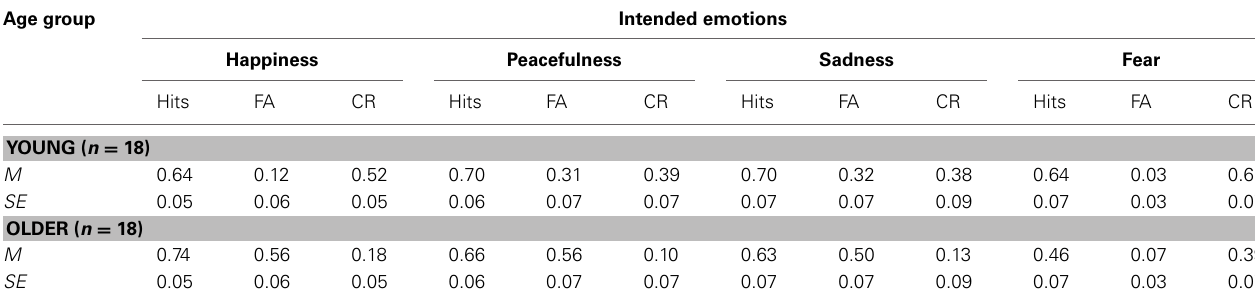
Table 2 | Hit rates, False Alarms Rates (FA) and Corrected Recognition (CR) by Emotions Catagory and Group Age.